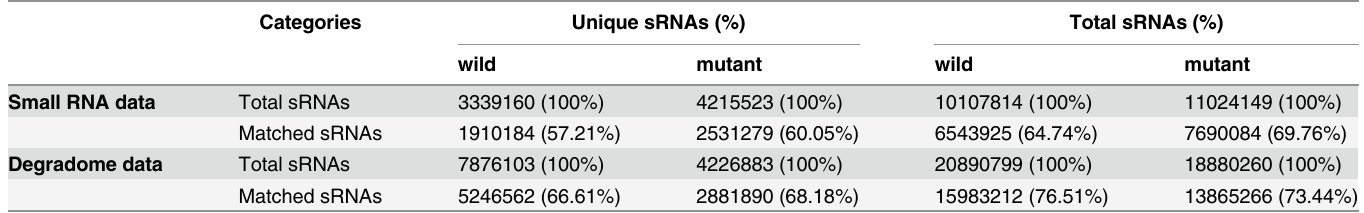
Table 3. Distribution of reads in the reference genome.